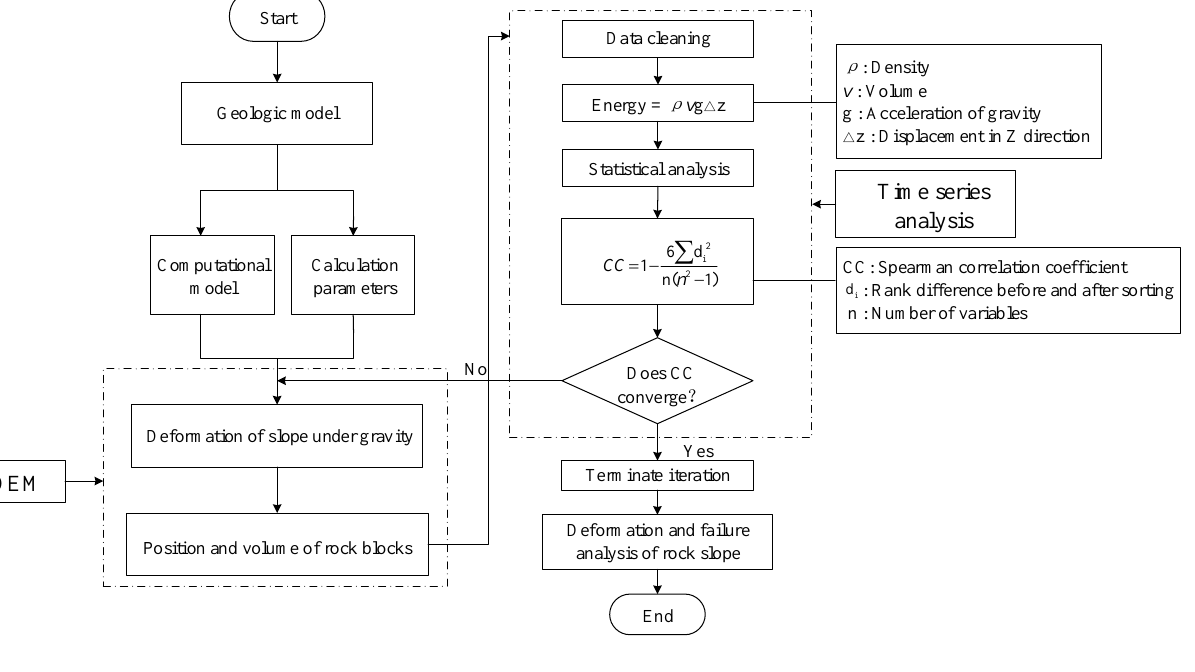
Figure 1. Workflow of the proposed